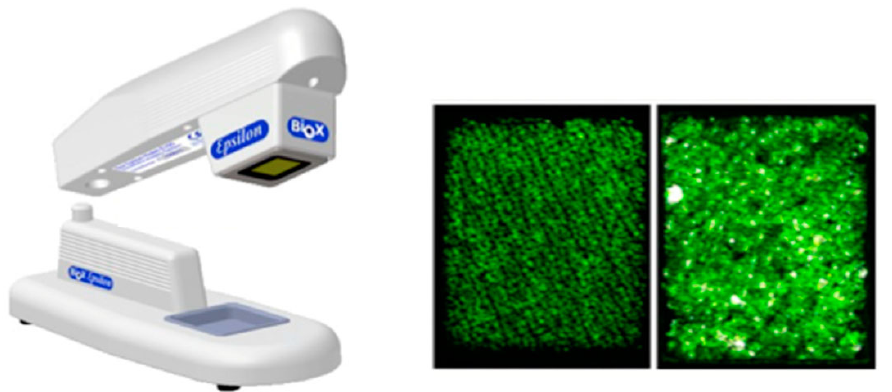
Figure 6. Left : the Epsilon instrument (Biox systems) with its in vivo parking stand; metal bezel can be seen on its head. Right : Typical contact image of the inner forearm skin and a contact image of the skin on the face with visible sweat gland activity—modified from Logger et al. [38].